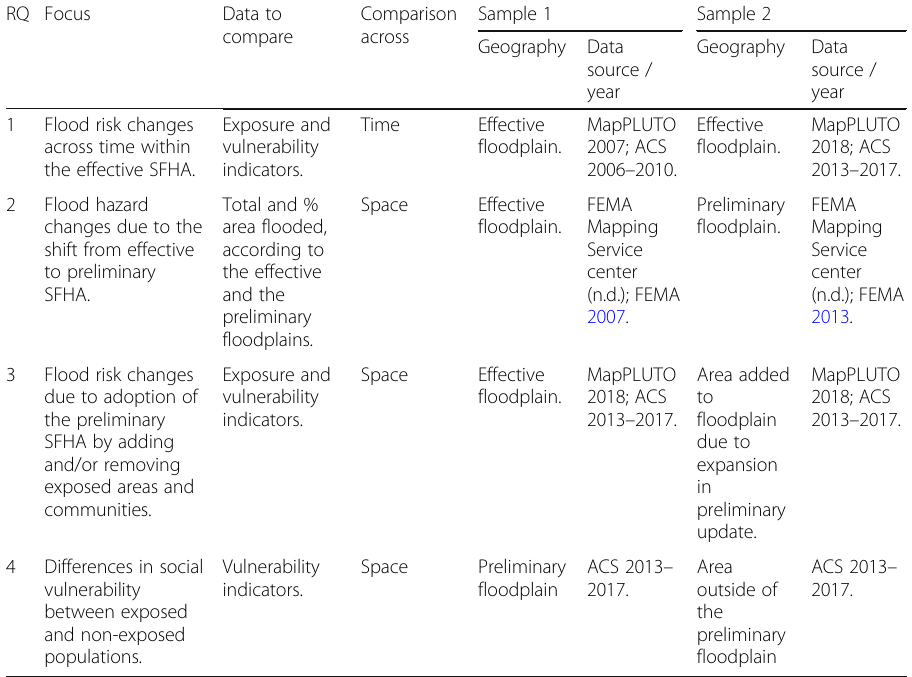
Table 4 Summary of the data compared per research question. The samples compared differed in the geography used to aggregate data or the year in which the data was collected RQ Focus Data to Comparison Sample 1 Sample 2 compare across Geography Data Geography Data source / source / year